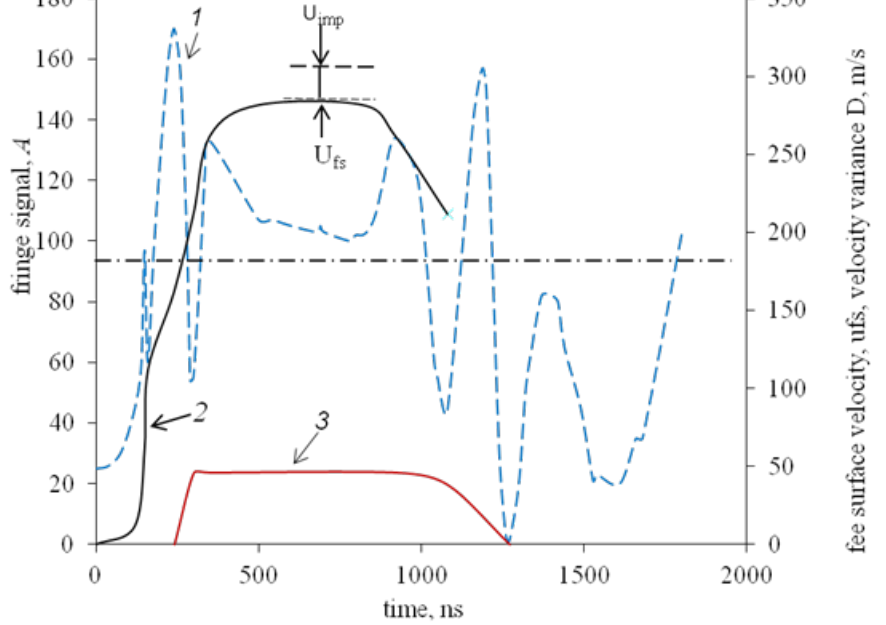
Figure 2. Interference signal (1), time-resolved velocity profile (2) and velocity variance (3) for the shock loading of a 5 mm 38CrNi4Mo steel target at an impact velocity of 320 m/s. Velocity defect equals to difference between velocity of impactor, Uimp, and maximum free surface velocity, Ufs.